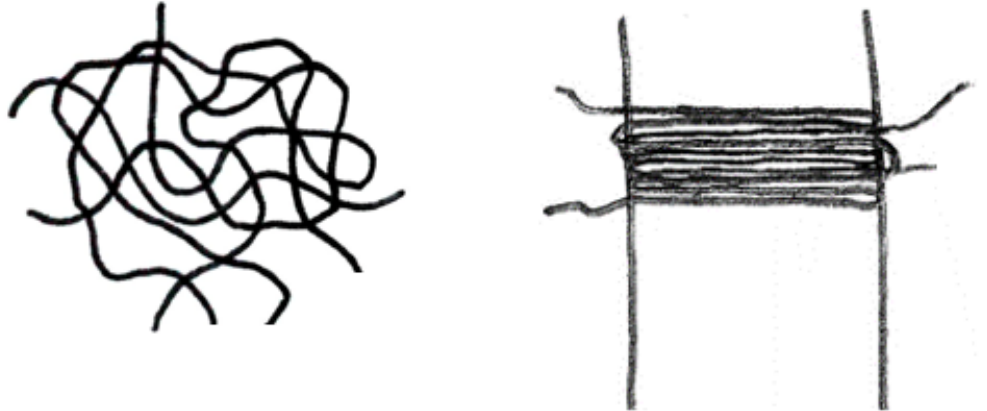
Figure 1. Schematic representations of the amorphous fraction ( left ) and the crystalline fraction ( right ). The vertical lines are indicating the border of the lamella.